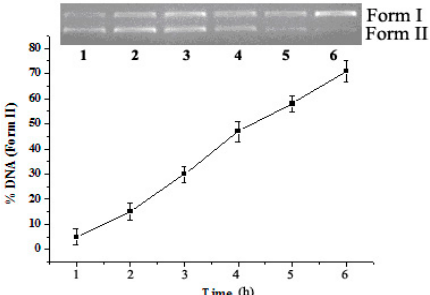
Figure 6. Time course of pUC19 DNA (0.008 µg/µL) cleavage promoted by 2b (3.13 × 10 − 7 mol/L) in pH = 7.4 buffers (5 mM Tris-HCl/10 mM NaCl) at 37 °C. Lanes 1–6, reaction time 6, 5, 4, 3, 2, 1 h, respectively.